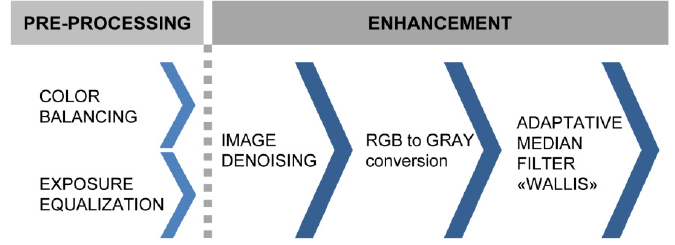
Figure 4. The proposed image pre-processing and enhancement pipeline.